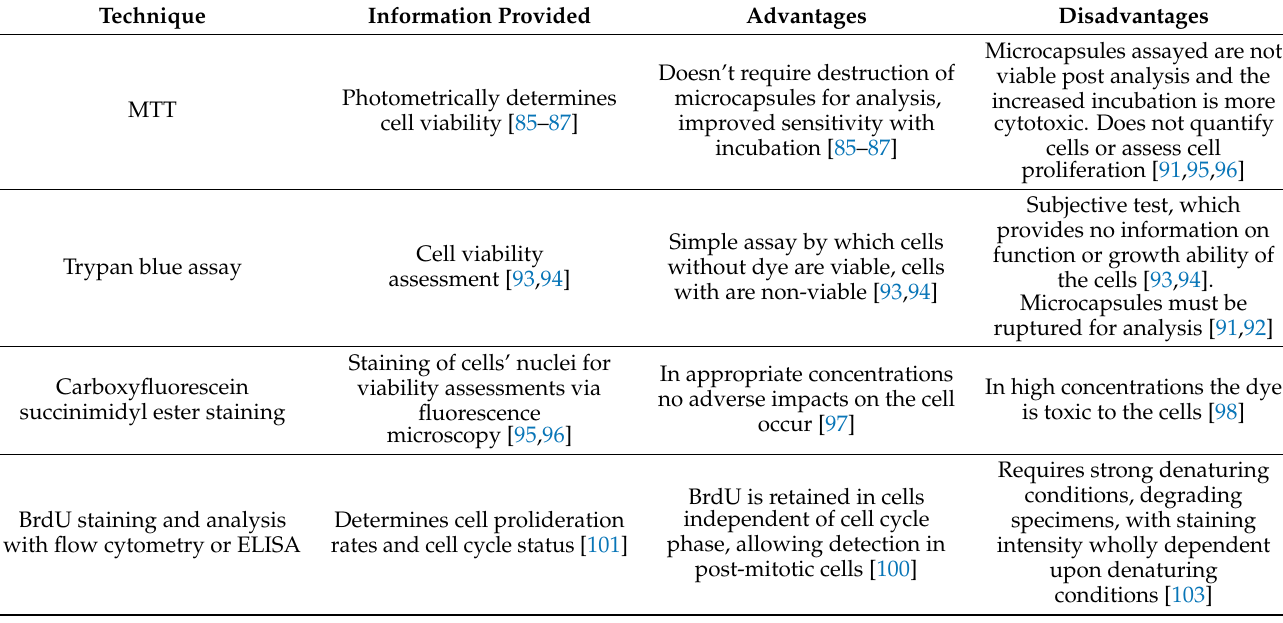
Table 2. Mechanisms, information provided by, advantages and disadvantages of Microencapsulated Islets and Cell Line analysis